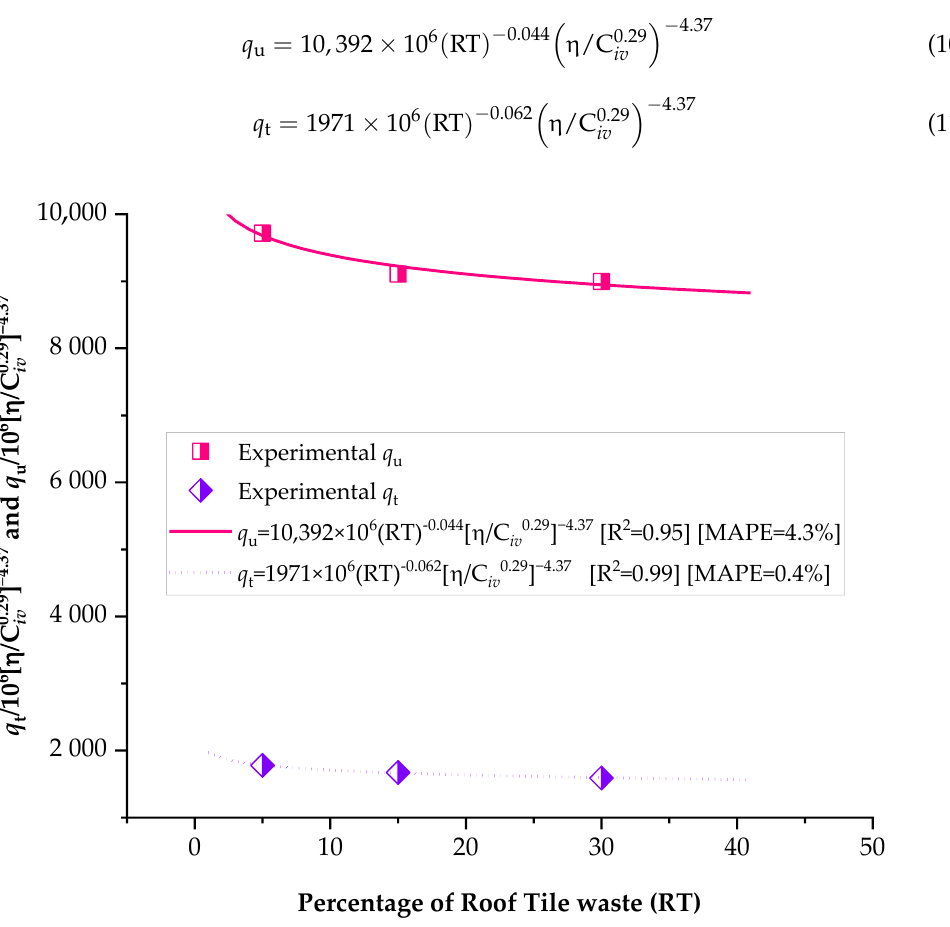
Figure 7. Estimate q u for any cement content and roof tile waste content using the η/C iv ratio (with b = 0.29 exponent) and the simple normalization resistances divided by 10 6 [η/C iv 0.29 ] −4